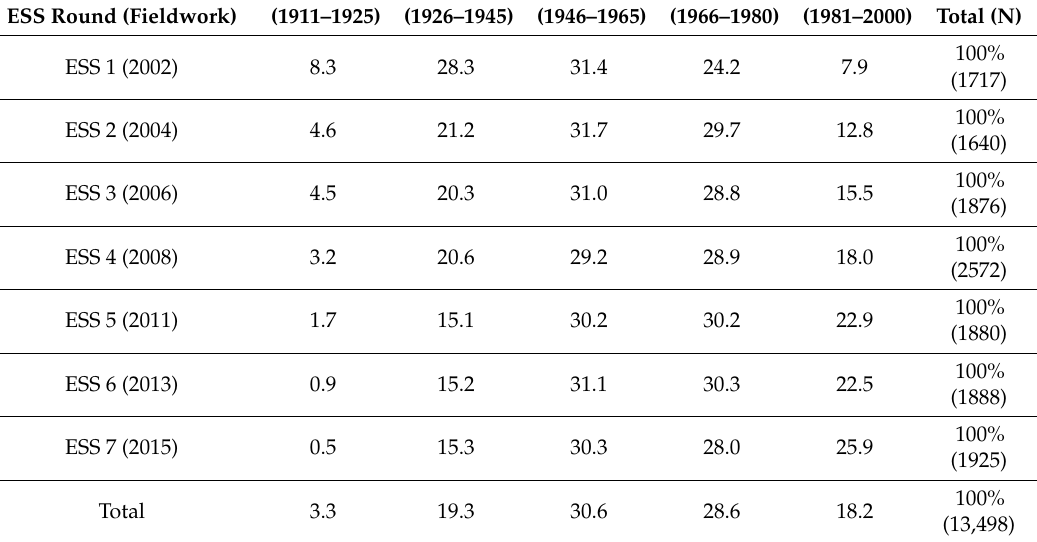
Table A3. Distribution of cases among birth cohorts and year of data collection.